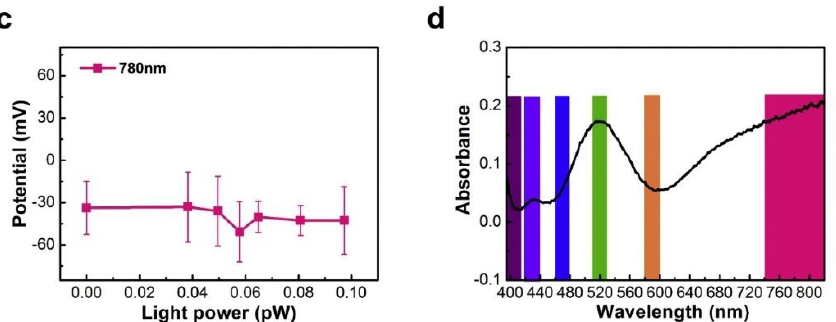
Figure 20. Using KPFM, Jian et al. [217] are able to study the modulation of the surface potential as a function of the light of power. ( a – c ) It is observed that with increasing light power toward the LSPR wavelength, more electrons are excited and flow to the Au nanoparticles resulting in a decrease in the surface potential of the Au nanoparticle. This switches upon the start of LSPR absorption resulting in a potential rise from − 36 mV to 30 mV and gradual saturation at longer wavelengths. ( d ) Narrow band-pass filters of visible light for six central wavelengths: 405 nm, 430 nm, 470 nm, 520 nm, 590 nm, and 780 nm corresponding to characteristics of the absorption spectrum of Au nanoparticles (the dip, the low absorption peak, LSPR absorption, LSPR peak, end of LSPR absorption, and the long wavelength side). Reprinted with permission from Ref. [217] Copyright Elsevier (2019).